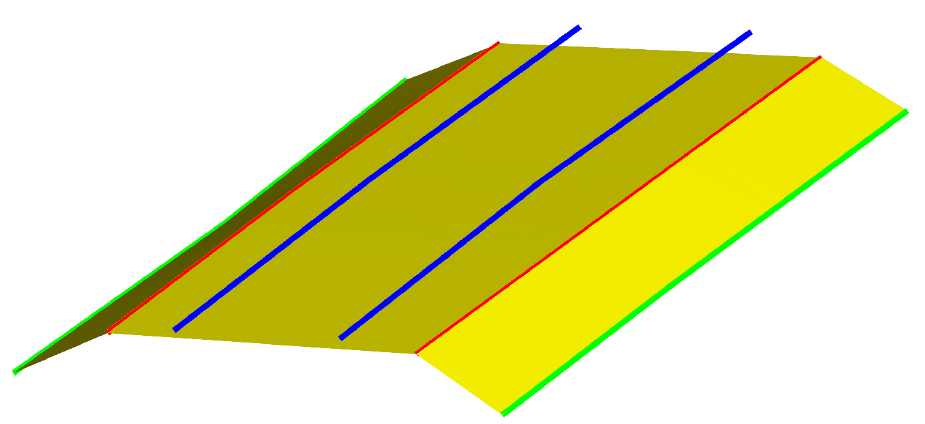
Figure 15. Three-dimensional linear elements modelling sample.